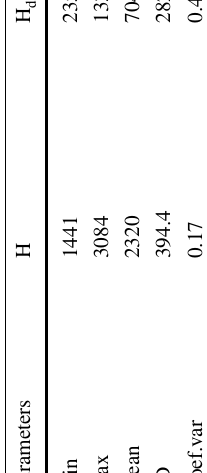
where α j is weight factor and equals 1 for all indicators, while correlation coefficient ( R 2 ) is equal to − 1. y j is the median of the scaled values of indicator j , and y ij is the scaled value of indicator j for model i . A higher value of GPI indicates more accurate model leading to better estimations. The values of GPI and ranking of the model are shown in Table 5. The GPI of the proposed models ranged from and K , respec- − 4.803 to 0.309 and − 5.70 to 0.23 for k d D tively. The highest GPI shows the best performing model. Form the Table 5, we observed among the models, 33% and 43% of the total models attain a positive GPI value and the other models have a negative GPI. The maximum value of models GPI is observed for model 23 (GPI = 0.309) for k d and model 63 (GPI = 0.230) for K models. Thus, it can be D inferred that the cubic model best estimates the e diffuse fraction and diffusion coefficient for the study area (Figs. 4, 5).